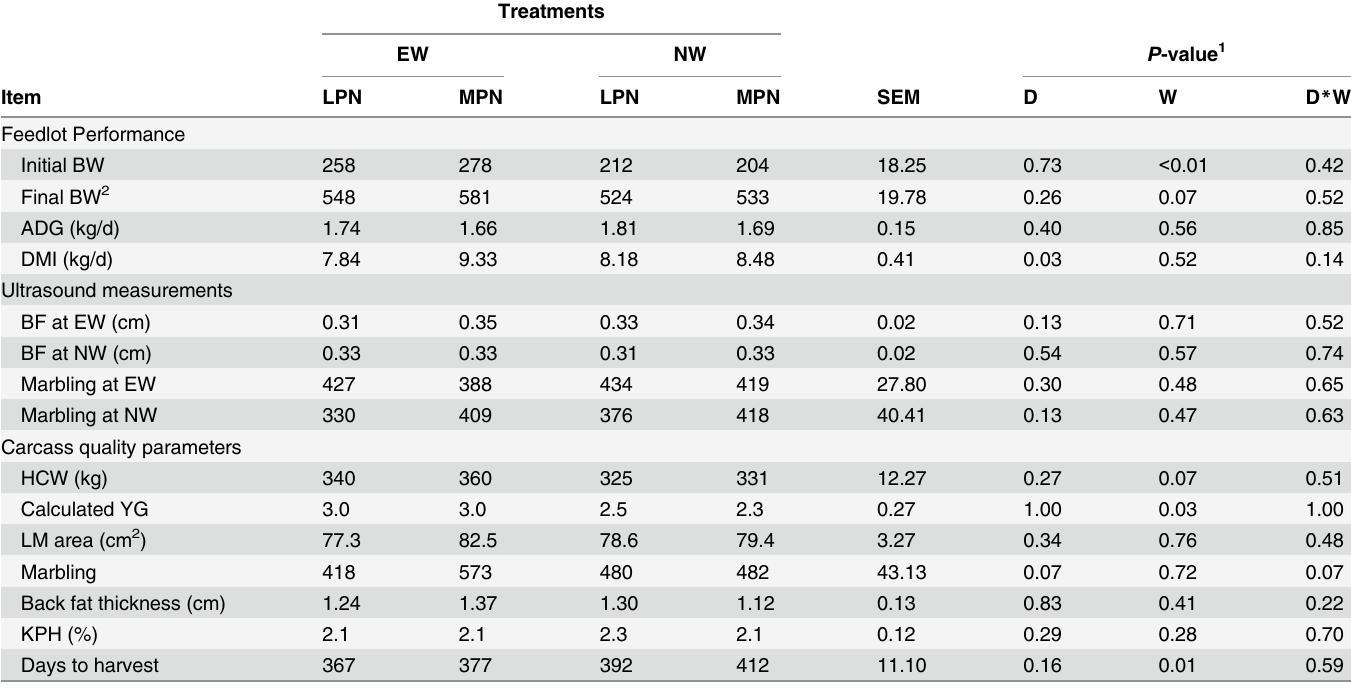
Table 2. Feedlot performance, ultrasound measurements and carcass quality parameters for Angus × Simmental steers (n = 20) from cows that received a low (LPN) or a medium (MPN) plane of nutrition (D) during the late gestation period. Weaning times (W) are early weaning (EW) and normal weaning (NW). Treatments EW NW P -value